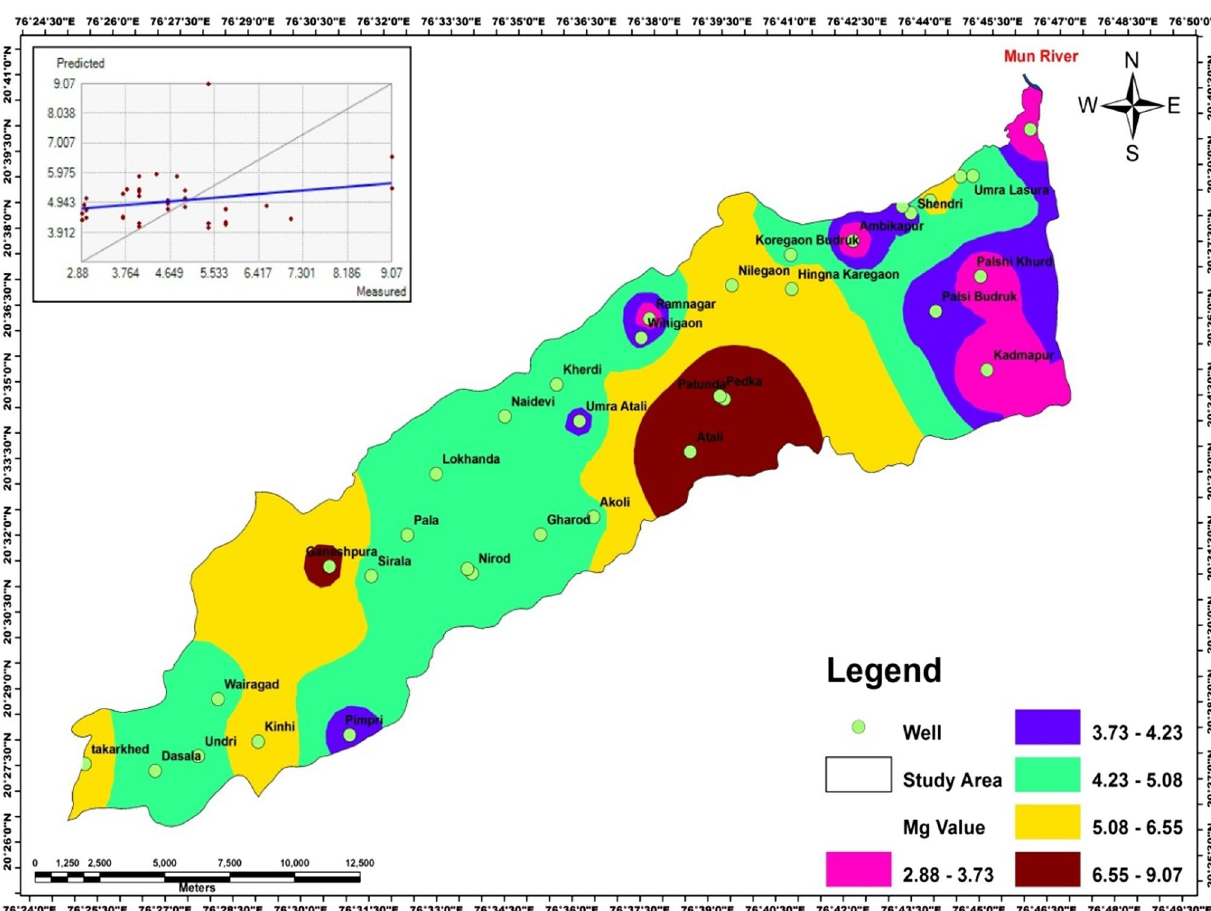
Fig. 5 Spatial distribution map of Mg post